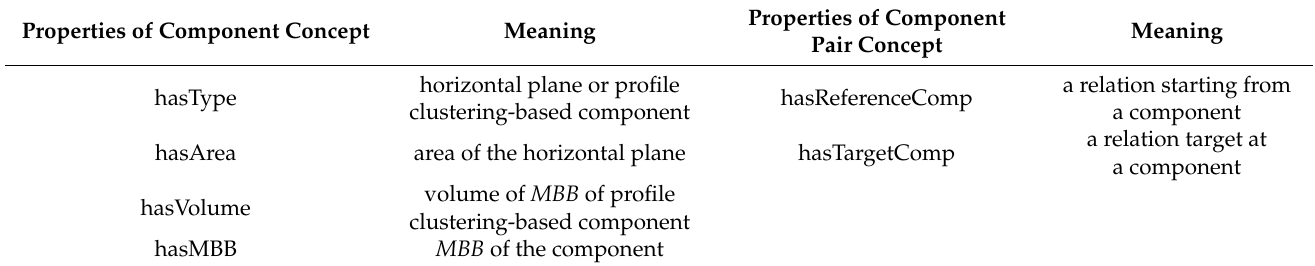
Figure 9. The scene ontology: ( a ) The scene ontology; ( b ) the spatial relationships. Table 2. Properties of ontology